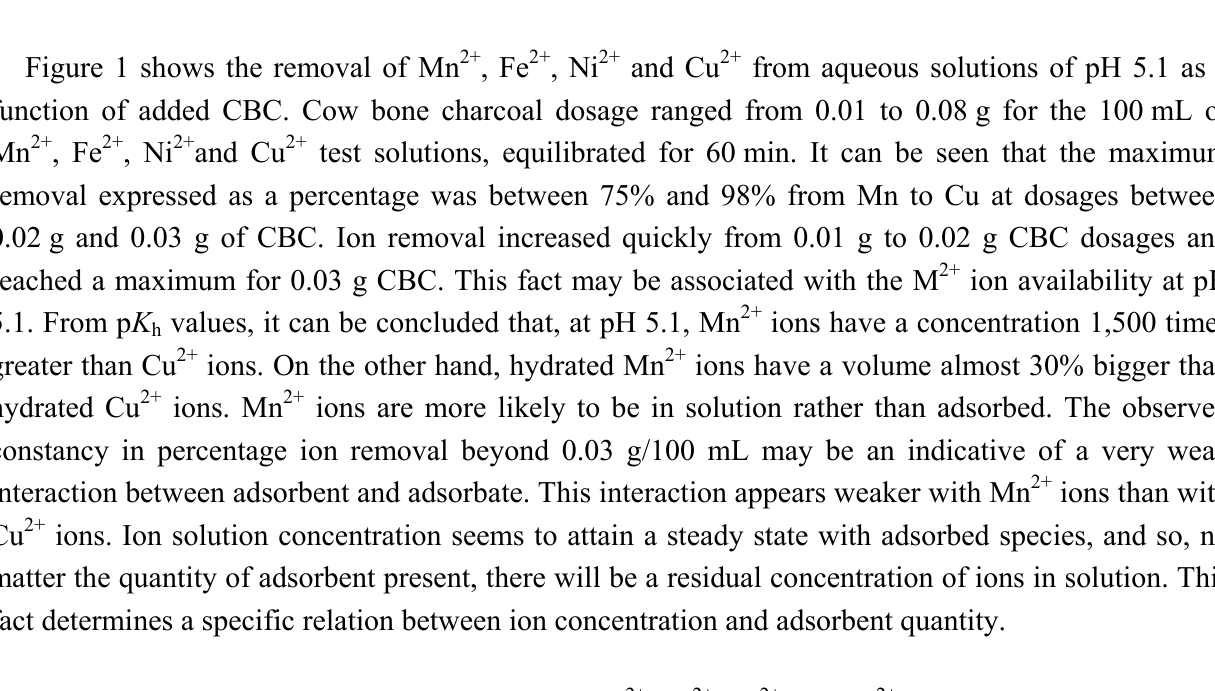
Figure 1. CBC adsorbent dosage effect on Mn 2+ , Fe 2+ , Ni 2+ and Cu 2+ removal. Conditions: C , 20 mg·L –1 ; time of contact, 60 min; pH 5.1 and temperature, 298 o